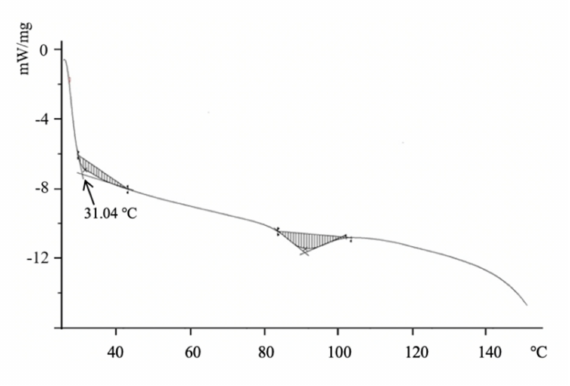
Figure 4. DSC curve of NTCII.